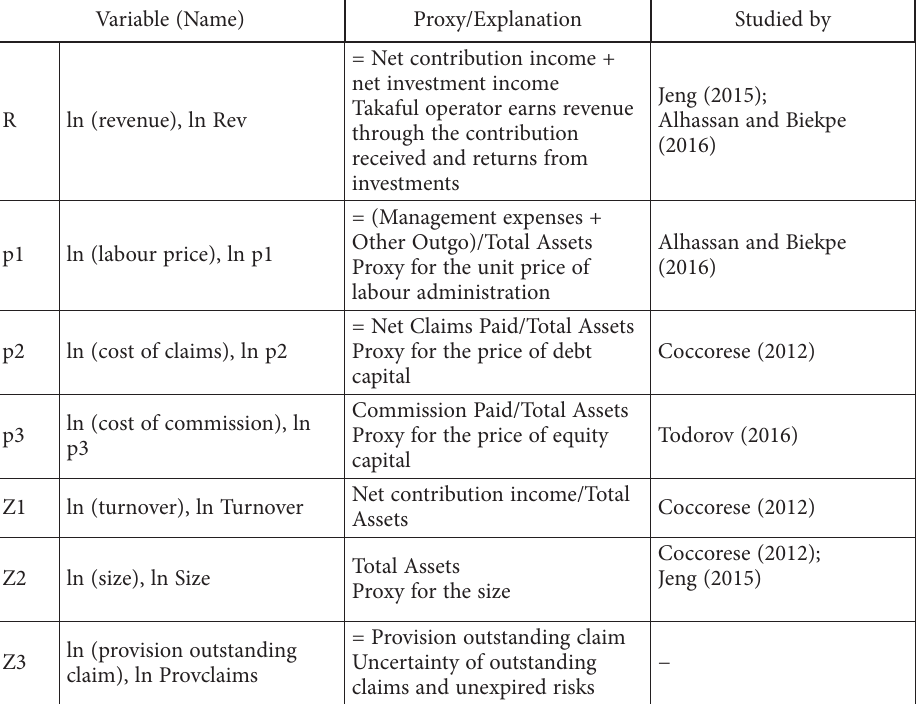
Table 2. Variables for the Panzar-Rosse competitiveness study Variable